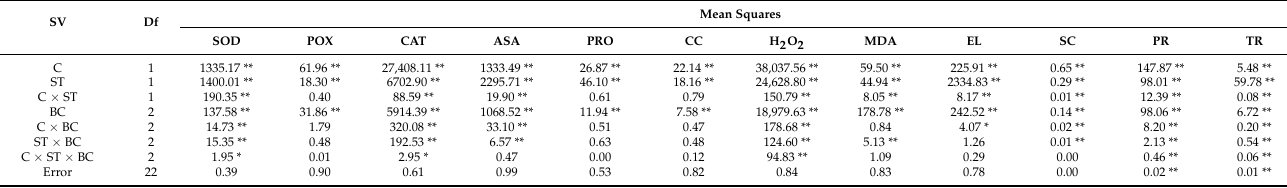
Table 1. Analysis of variance in the effects of cultivars (C), sampling time points (ST), and different brassinolide concentrations (BC),as well as their interactions, on the superoxide dismutase activity (SOD), peroxidase activity (POX), catalase activity (CAT), ascorbic acid (ASA), proline (PRO), carotenoids (CC), hydrogen peroxide (H 2 O 2 ), and malondialdehyde (MDA) content, as well as electrolyte leakage (EL), stomatal conductance (SC), photosynthetic rate (PR), and transpiration rate (TR).